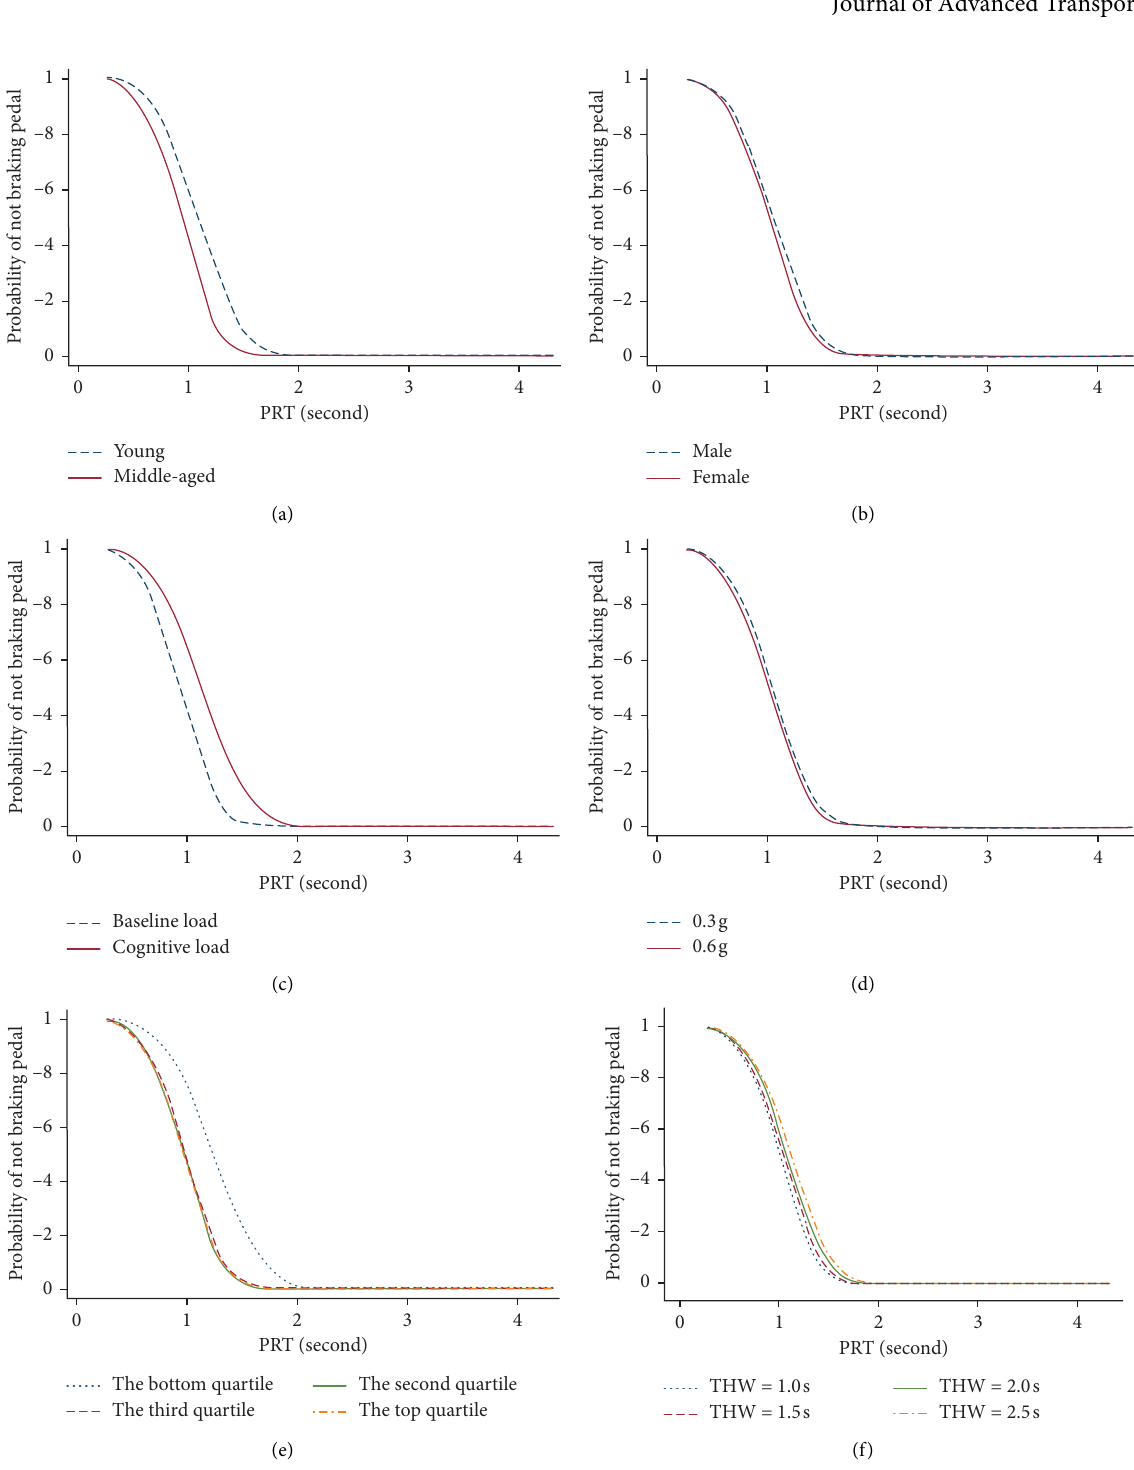
Figure 4: Comparisons of probability of not braking pedal for (a) young and middle-aged drivers; (b) male and female drivers; (c) baseline load and cognitive load; (d) 0.3g and 0.6g of lead vehicle’s deceleration rate; (e) different levels of WMC; (f) 1.0 s, 1.5s, 2.0 s, and 2.5 s of the initial time